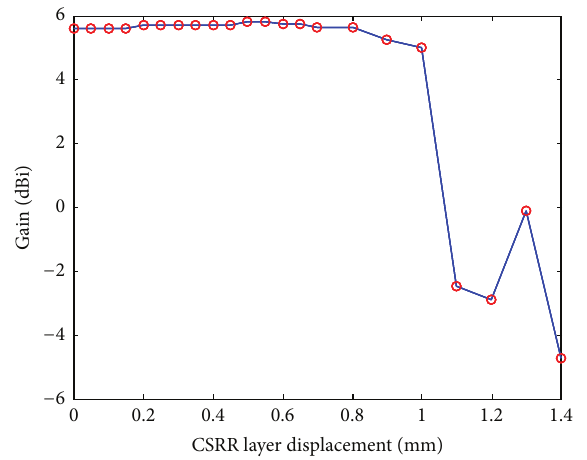
Figure 10: The simulation results showing the variation of the antenna gain due to the displacement (misalignment) of the CSRR layer along the feed line.